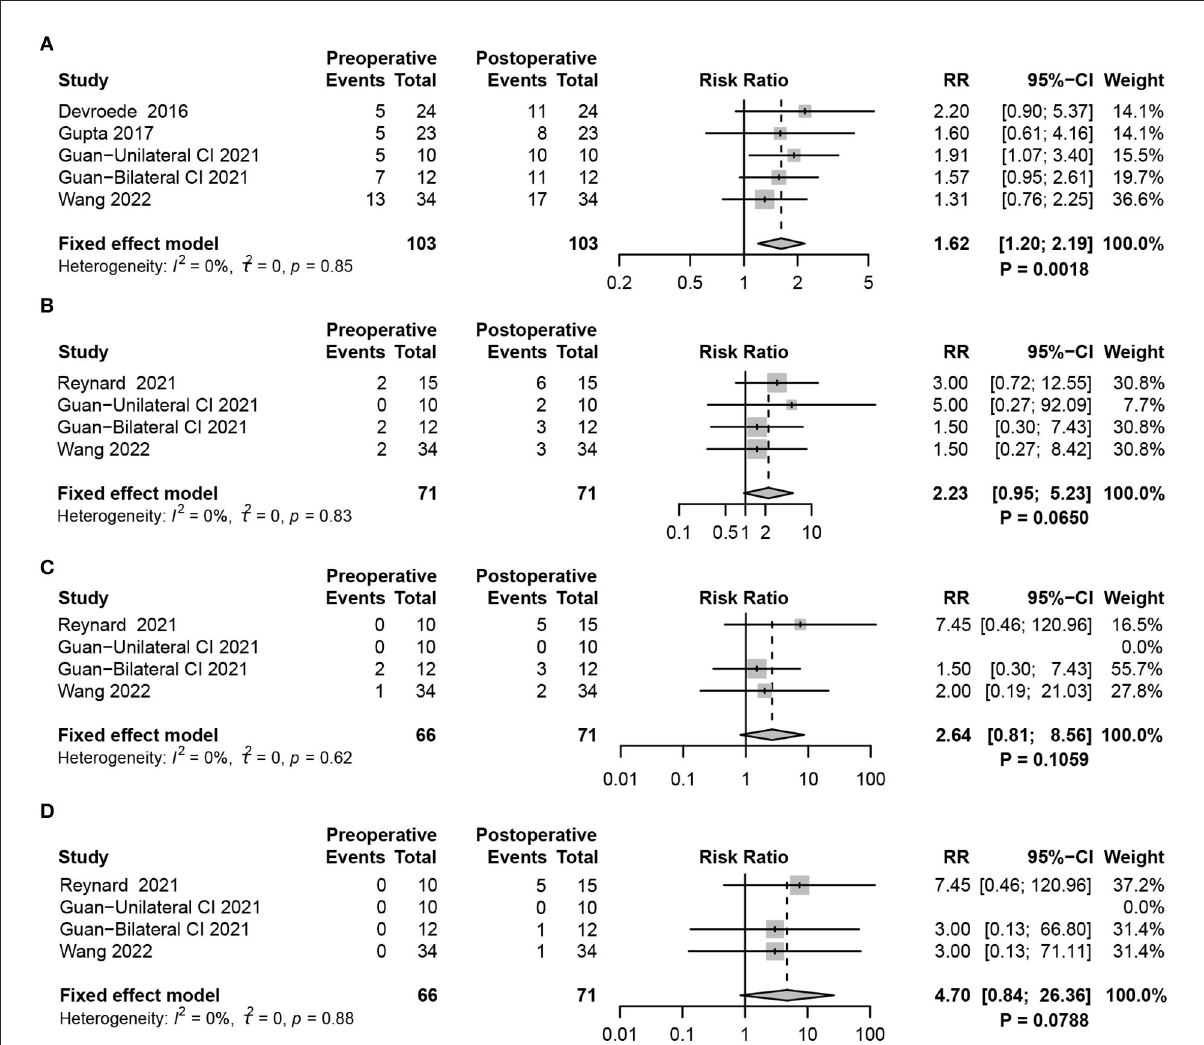
FIGURE4 Forest plots showing semicircular canal function test results between pre- and post-surgery groups. (A) Response to the caloric test. (B–D) vHIT, including (B) HSC (C) PSC, and (D) ASC function tests. Study, included studies for Research on meta-analysis; Preoperative, results of vestibular function test before operation; Postoperative, results of vestibular function test after operation; Events, number of people with abnormal vestibular function test results; Total, total number of patients in the study; RR, relative risk; 95%-CI, 95% confidence interval; Weight, weight of each study in